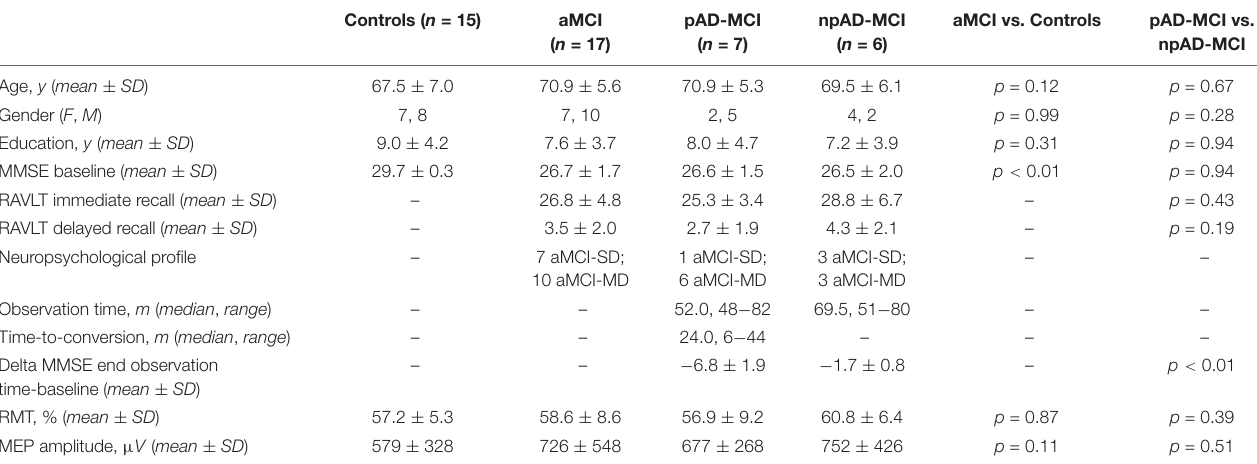
TABLE 1 | Demographic, clinical, and neurophysiological characteristics of